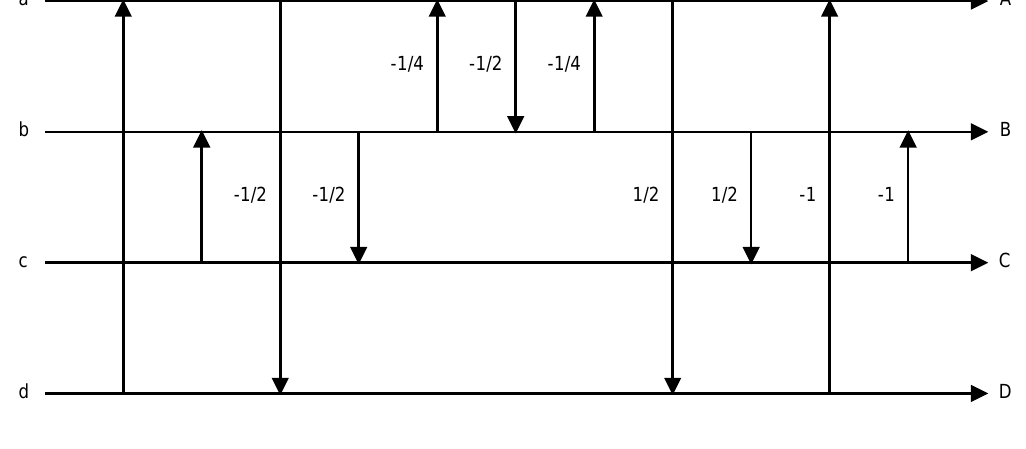
Figure 22. Implementation of 2 × 2